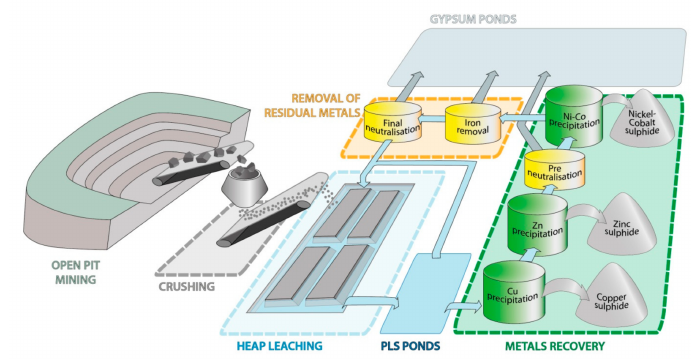
Figure 1. Talvivaara mining